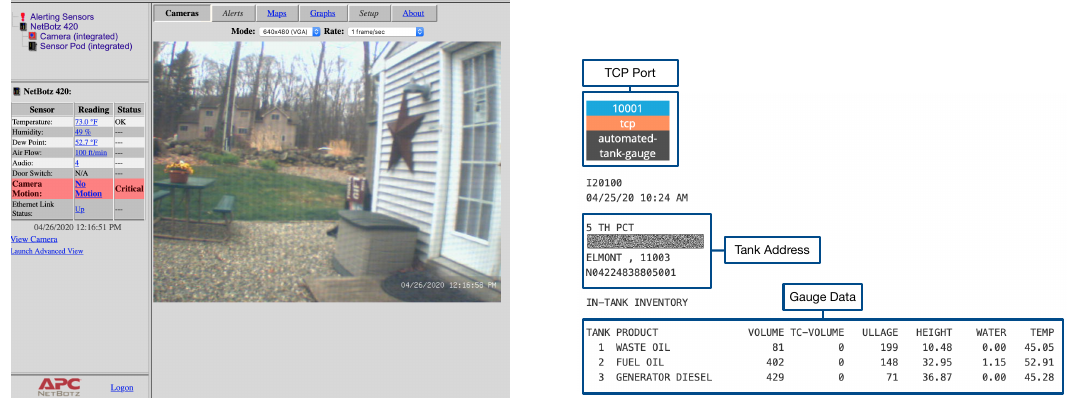
Figure A7. Open NetBotz installation (left) and data from an automatic tank gauge (right).